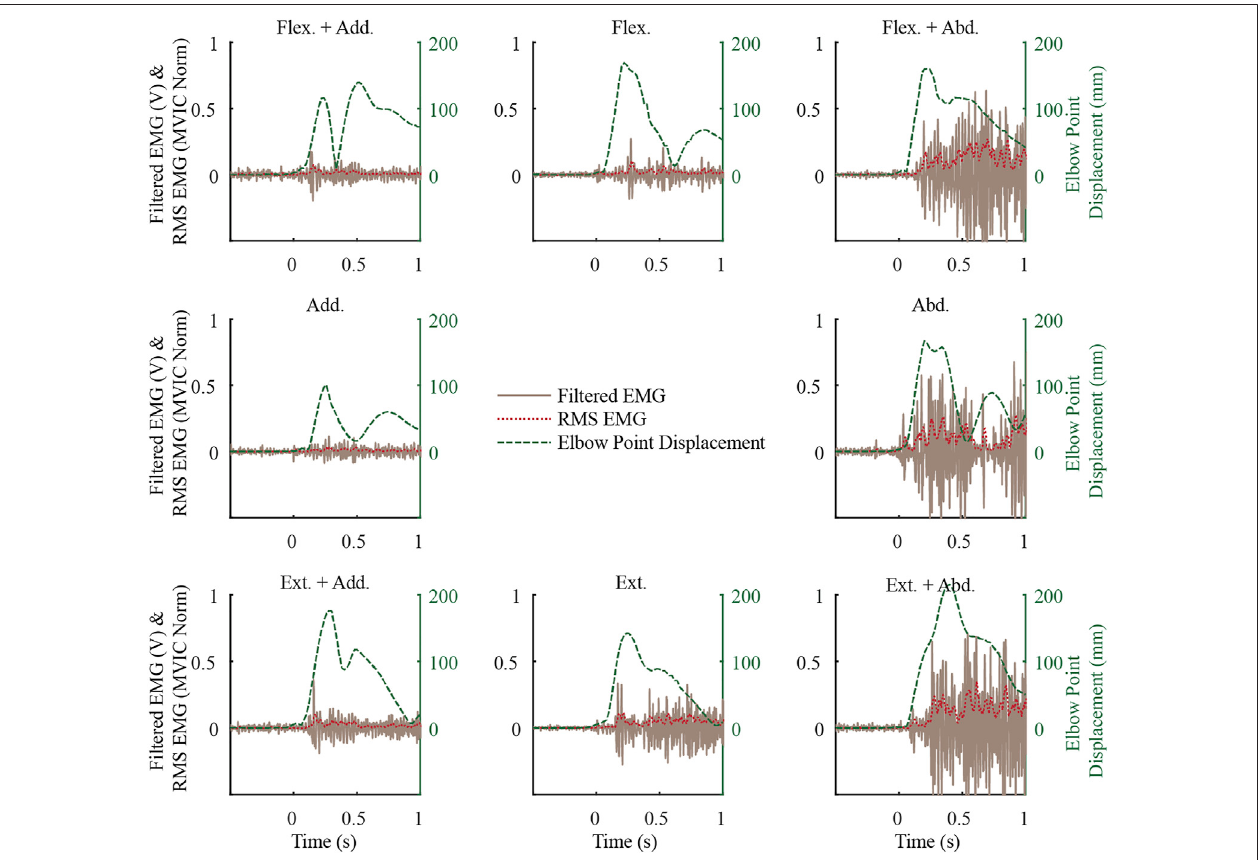
FIGURE3| Exemplarmiddledeltoid(MDELT)muscleactivityfromafemalesubjectforthe fi rstrepetitionofeachloadingdirectionshownalongwiththeelbowpoint displacement data. See Figure 2 for a description of the direction short forms.